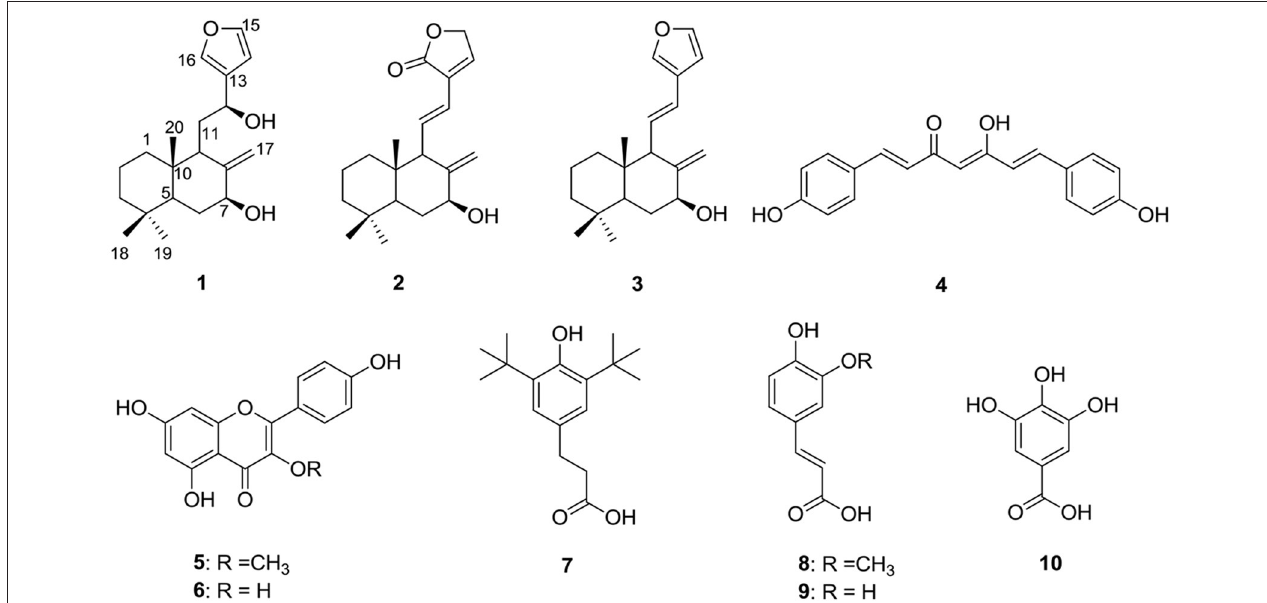
FIGURE 1 | Structure of compounds from R. purpurea rhizomes ( 1–10 ).